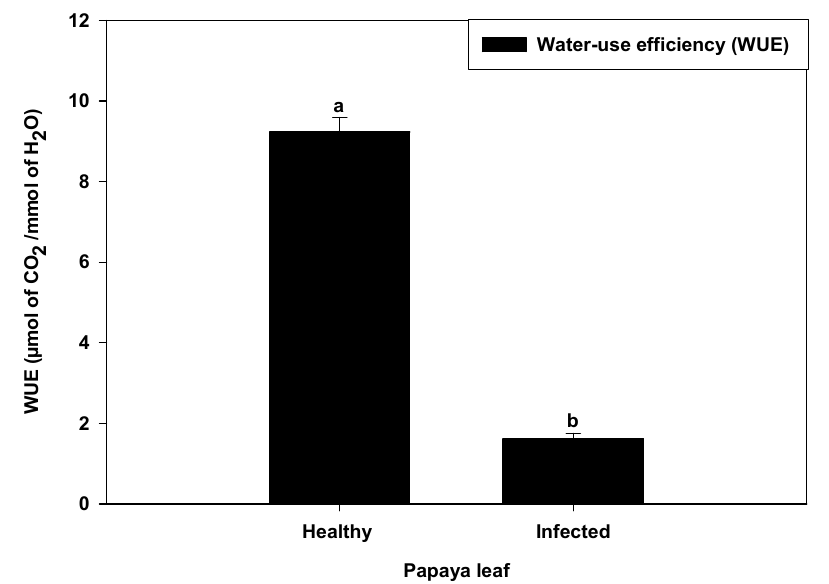
Figure 5. Water use efficiency in papaya leaves. Error bars shown as the standard error of mean (SE) was computed by Sigma Plot 14, different letters above the error bars show significant differences at p ≤ 0.05.